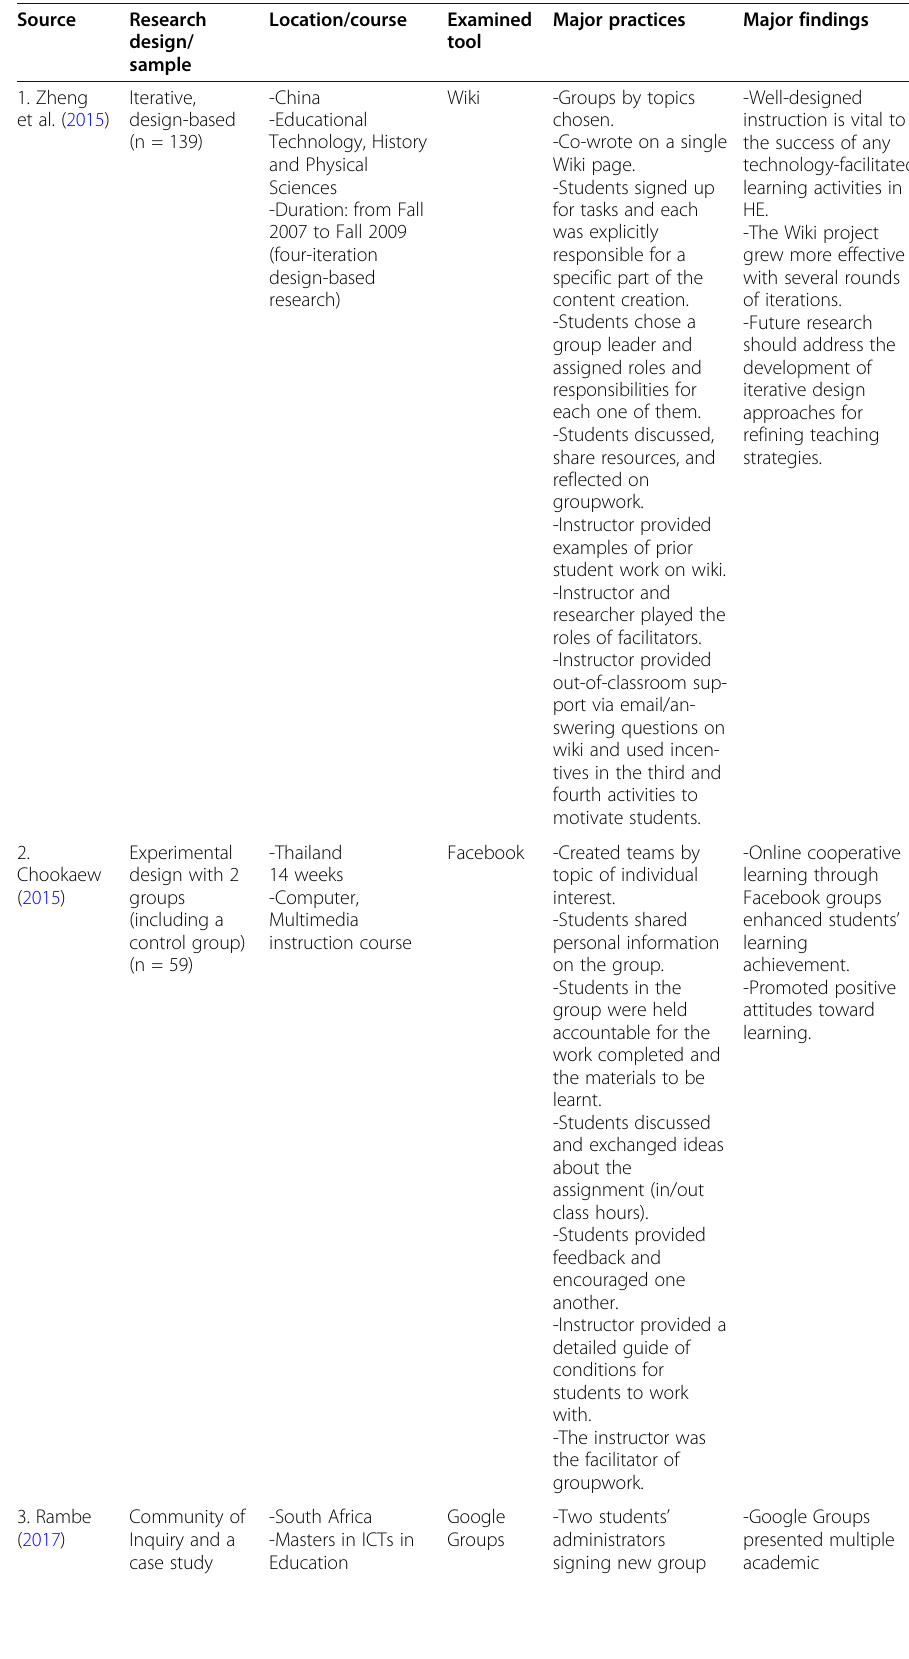
Table 4 The analysis of sources included in the integrative